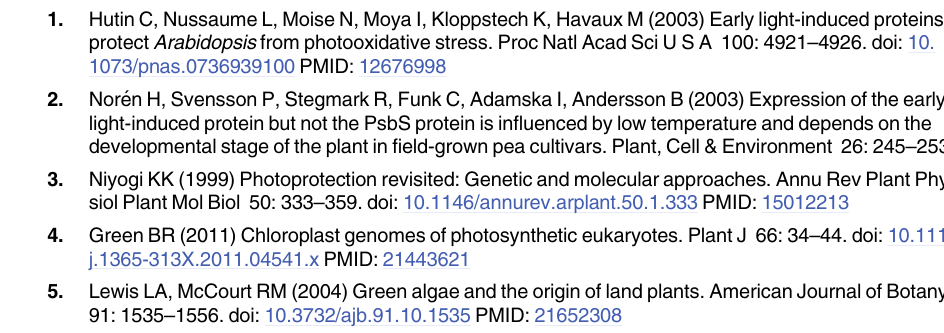
S1 Table. Micromonas commoda (RCC299) chloroplast genes as well as select chloroplast- targeted and light-harvesting related genes that could be analyzed